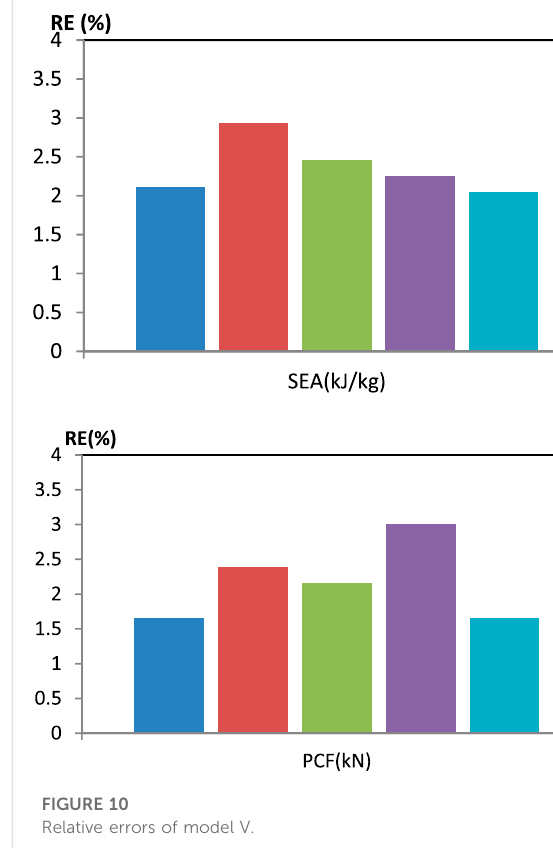
FIGURE 10 Relative errors of model